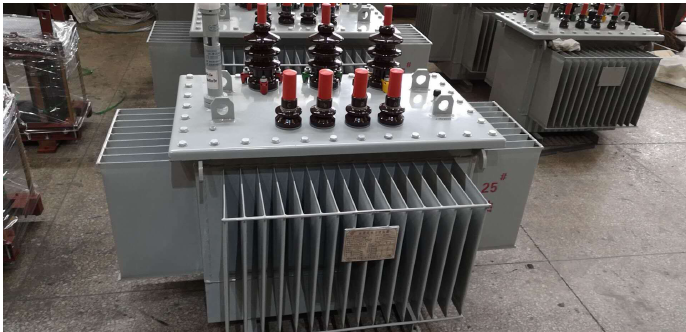
Figure 3. Power transformer equipment studied in our